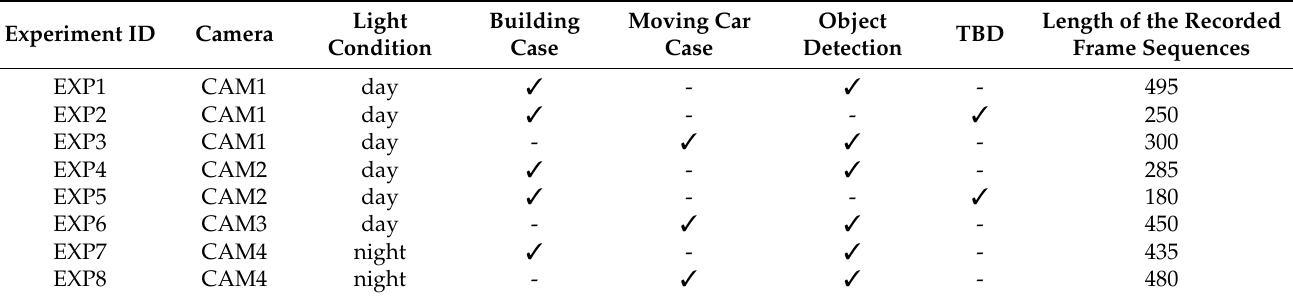
Table 2. Considered experimental condition